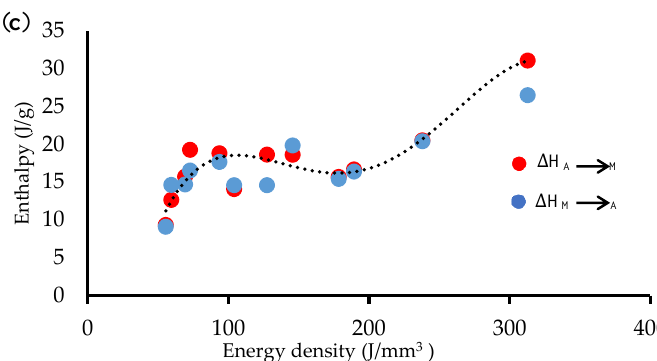
Figure 6. DSC curves of SLM NiTiHf samples with energy densities ( a ) below 100 J / mm 3 and ( b ) above 100 J / mm 3 . ( c ) Enthalpy of transformation as a function of energy density. ∆ T shows thermal hysteresis defined as A f –M s and the shaded shows area where enthalpy of transformation was obtained.